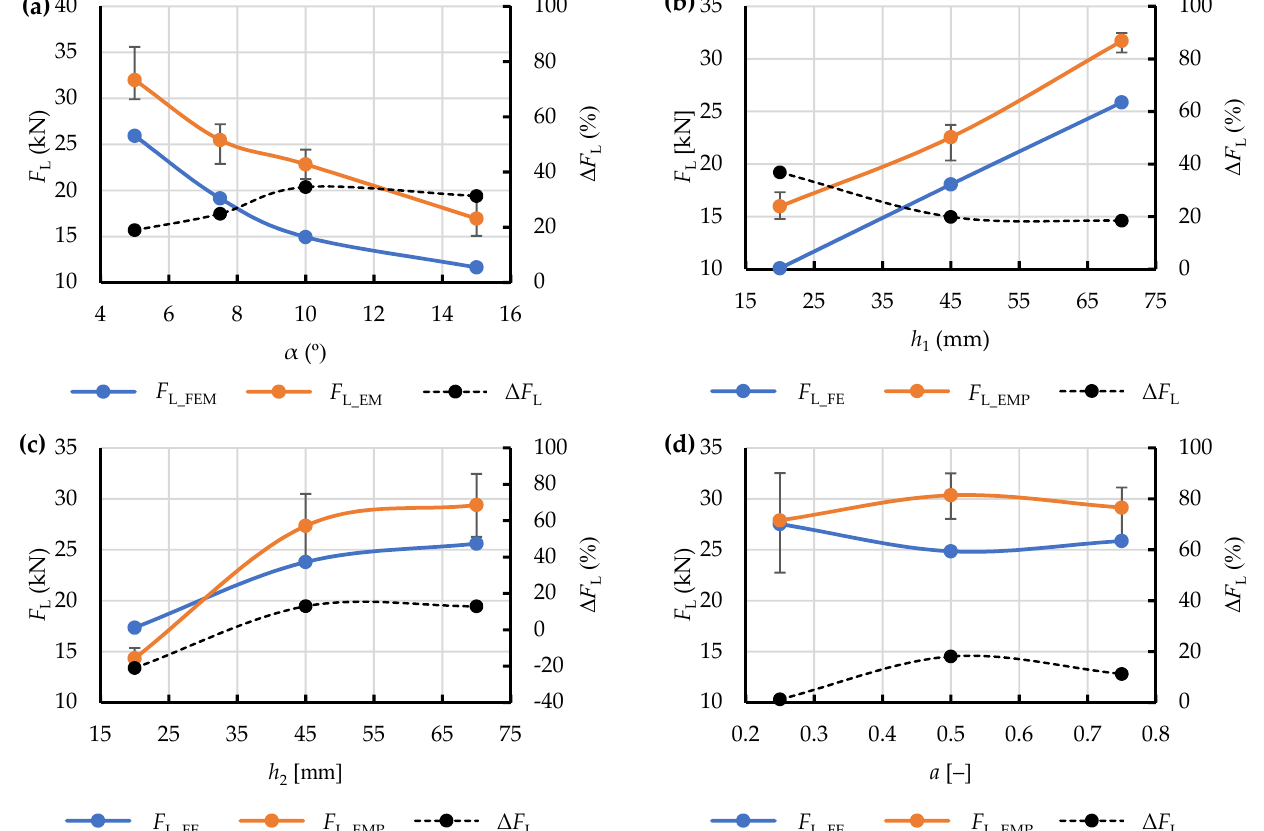
Figure 14. Comparison of the curves representing the relationship of the maximum force during dry ice extrusion and the adopted variable geometric parameters of the analysed single-hole dies for: maximum predicted force ( F L_FEM ), maximum observed force ( F L_EMP ) and their percent difference Δ F L for the die groups CS ( a ), WK ( b ), WP ( c ) and WKWP ( d ). This hypothesis needed to be verified. To this end, at all the test points (i.e., the values of the geometric parameters of the respective dies and their corresponding values of F L_FEM and F L_EMP ) mathematical functions were derived, describing the percent difference between the obtained values in relation to the observed extrusion resistance: